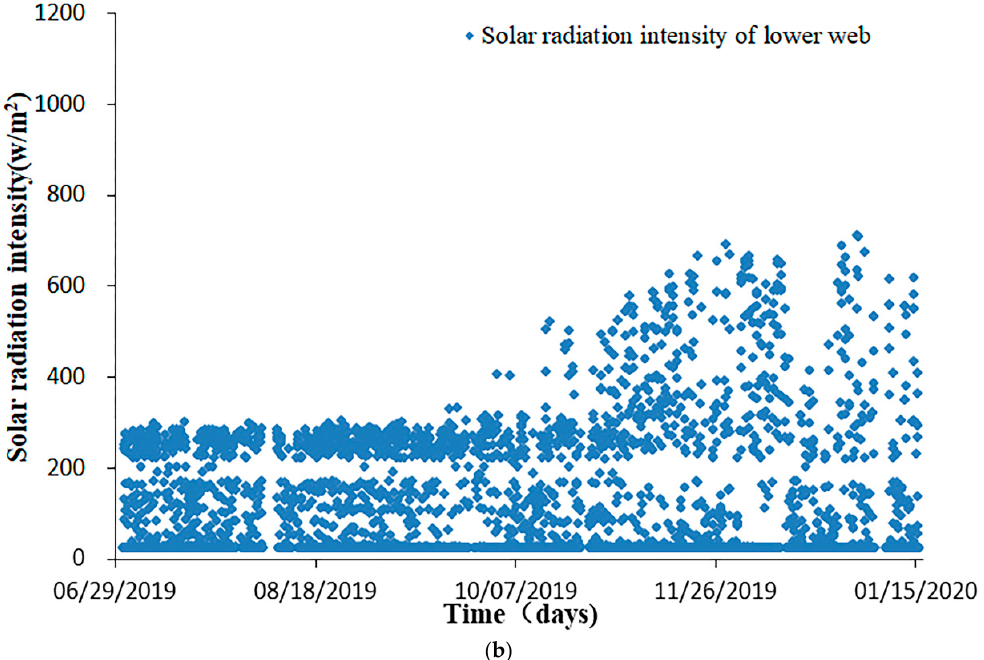
Figure 4. Solar radiation intensity on different parts of the bridge (sampling frequency: 1 time/h). ( a ) Solar radiation variations on the top slab from 29 June 2019 to 15 January 2020; ( b ) solar radiation variations on the lower web from 29 June 2019 to 15 January 2020.